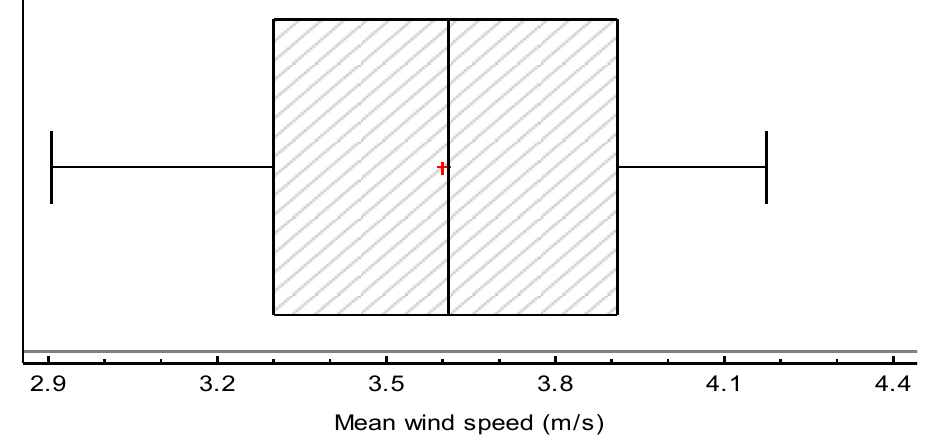
Figure 4. Box and whiskers plot showing range of mean wind speed across the stations.